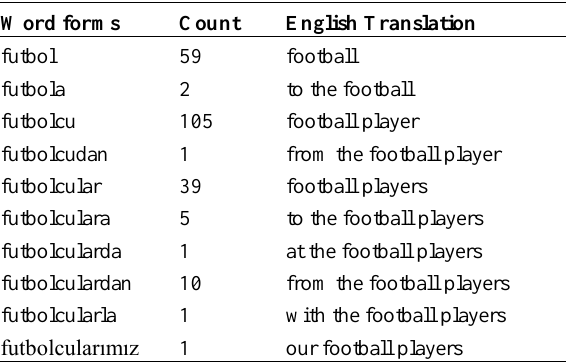
Table 1. Some example data set observations of the word forms whose root are “ futbol